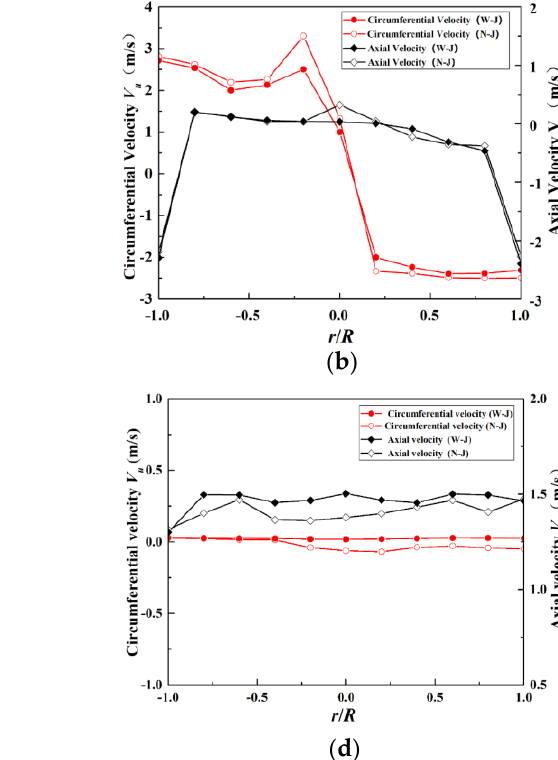
Figure 9. The distributions of circumferential and axial velocity in conical section with or without J-grooves. ( a ) Q* = 53%, ( b ) Q* = 69%, ( c ) Q* = 82%, ( d ) Q* = 100%.